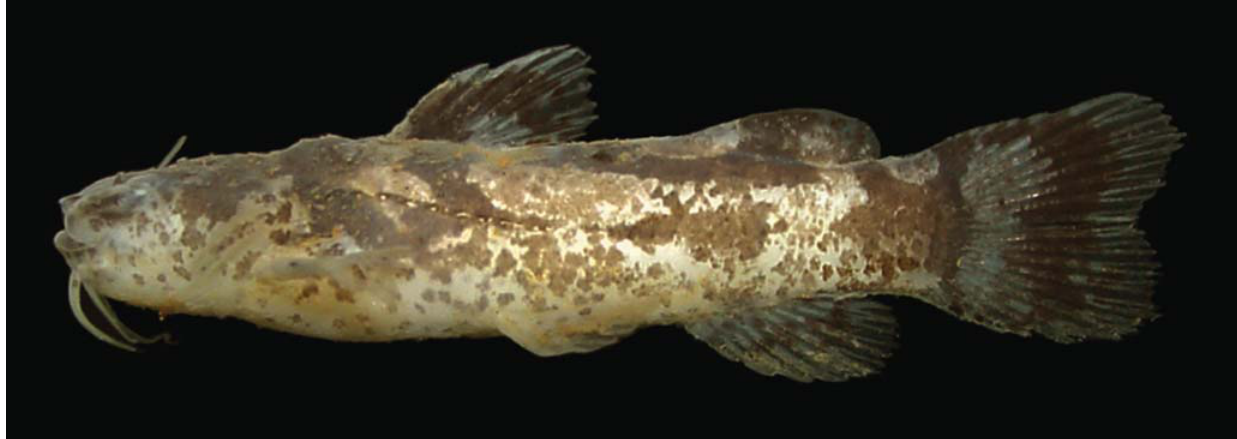
Fig. 2. Microglanis maculatus , paratype, MZUEL 5925, 20.5 mm SL, ribeirão Pouso Alegre, tributary of rio dos Patos, upper rio Tocantins basin, Barro Alto, Goiás State, Brazil.